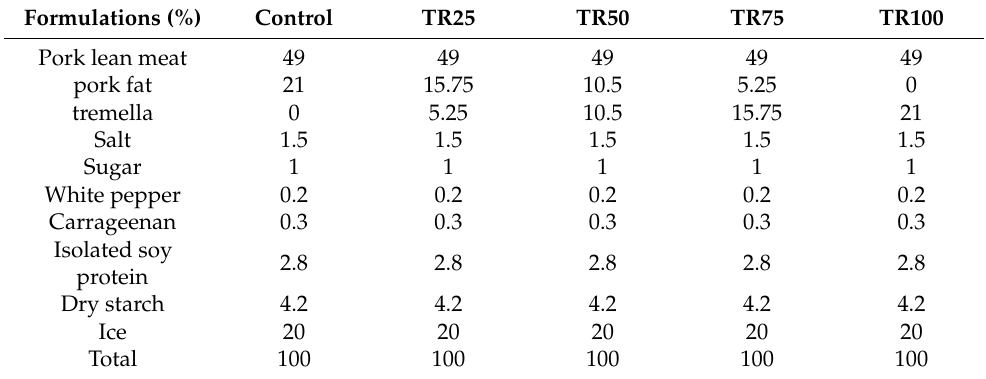
Table 1. Formulations of sausages with pork fat replaced by tremella. Formulations